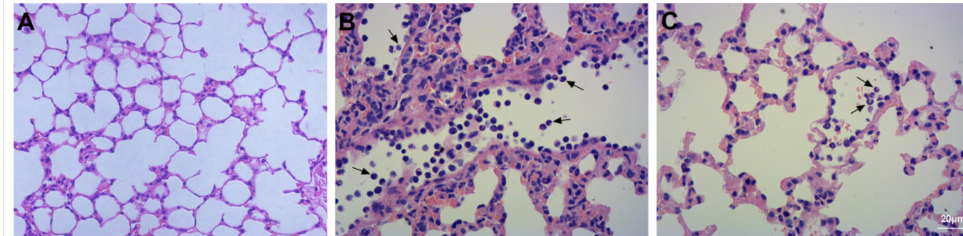
Figure 3. Detection of neutrophil infiltration: ( A ) Con group; ( B ) Bl group; ( C ) Bl + MSC group; Black arrows indicate neutrophils ( A – C , 400 × magnification).